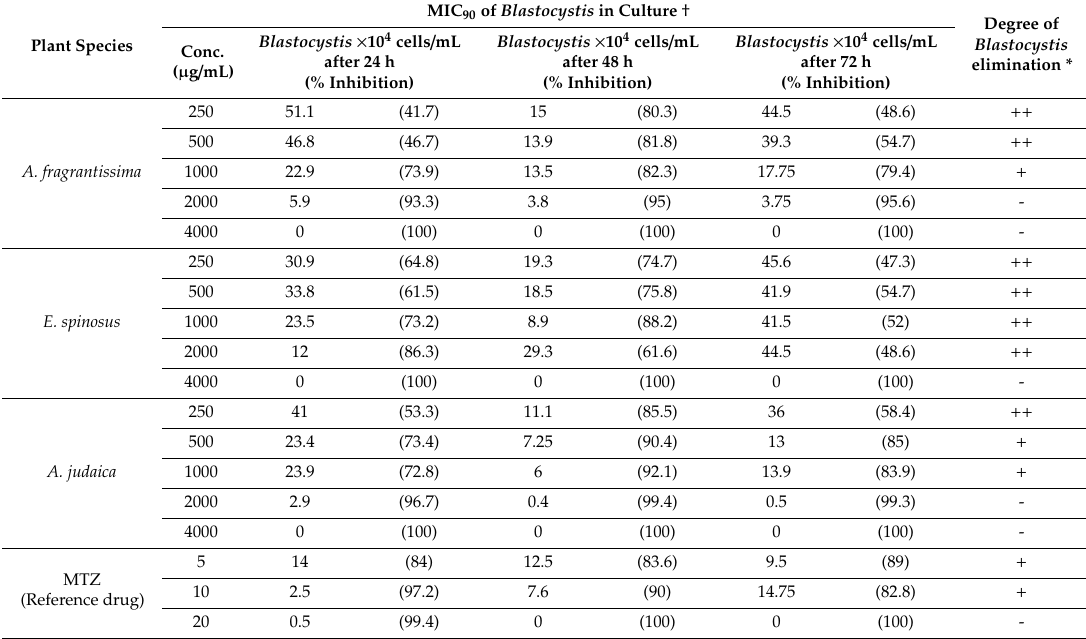
Table 3. Anti- Blastocystis activity according to MIC 90 of the three Egyptian herbal extracts and MTZ.